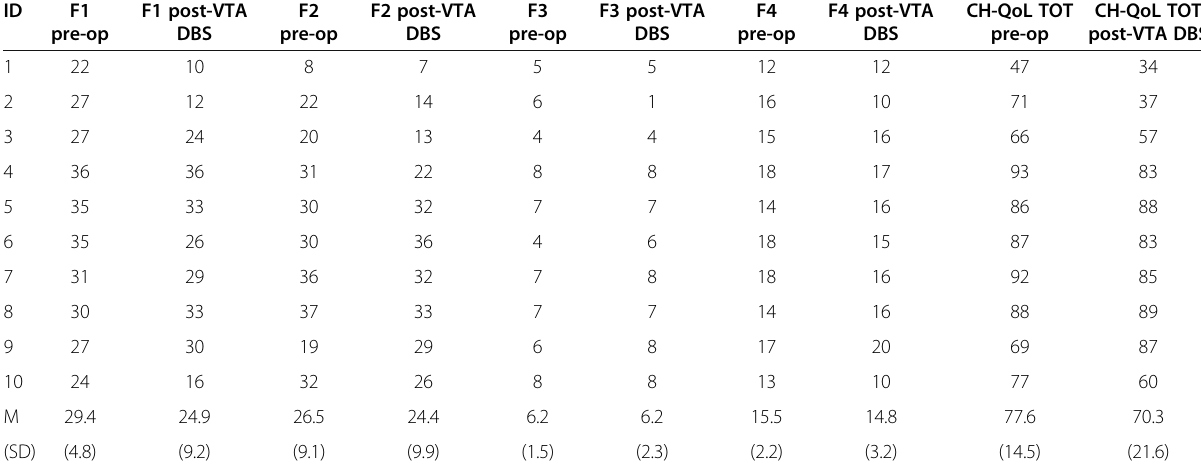
Table 2 Cluster headache quality of life scale (CH-QoL) total and subscale scores before (pre-op) and after ventral tegmental area deep brain stimulation